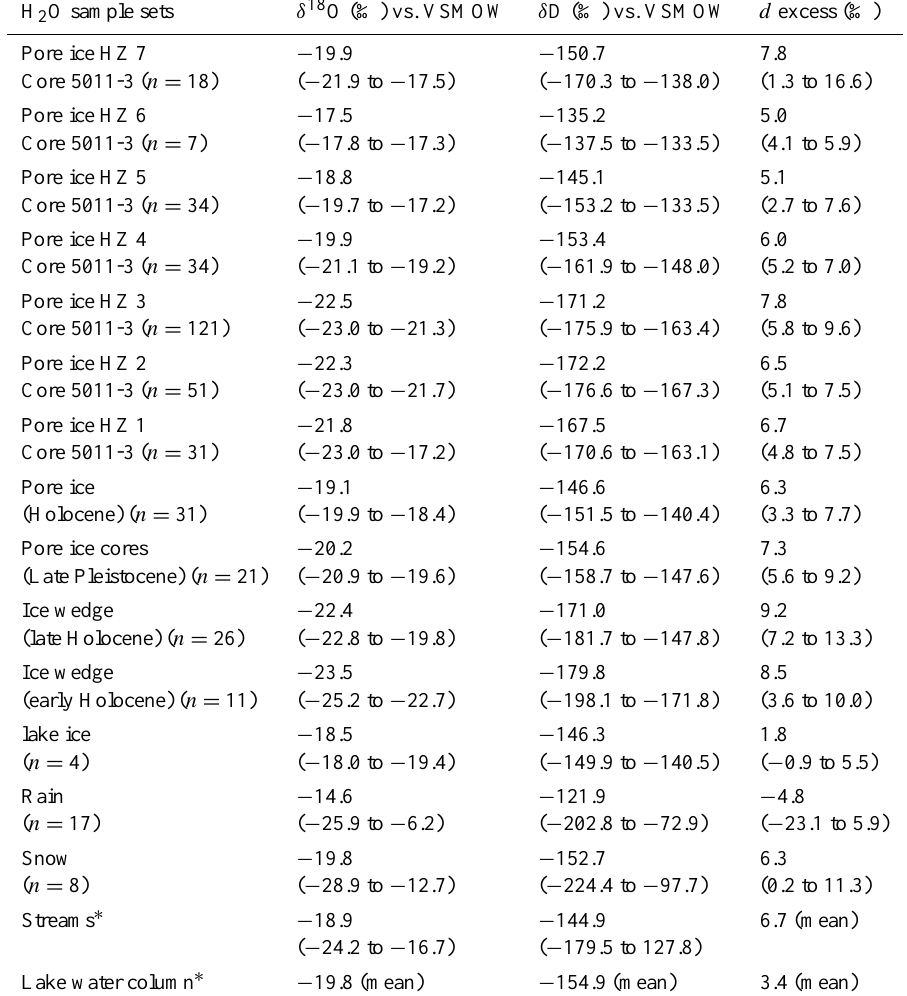
Table 1. Mean values and range ( δ 18 O, δ D, d excess) for H 2 O sample sets of pore ice, precipitation, and surface